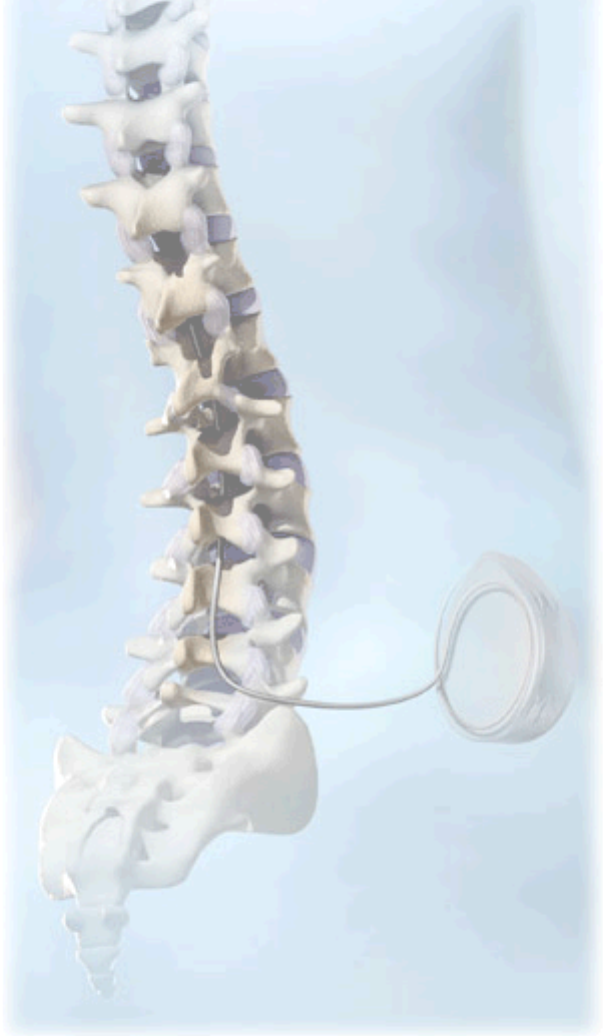
Figure 1. Image of the spine illustrating placement of the catheter into the intrathecal space which is connected to an implanted pump containing the drug reservoir. Reprinted with the permission of Medtronic, Inc.©